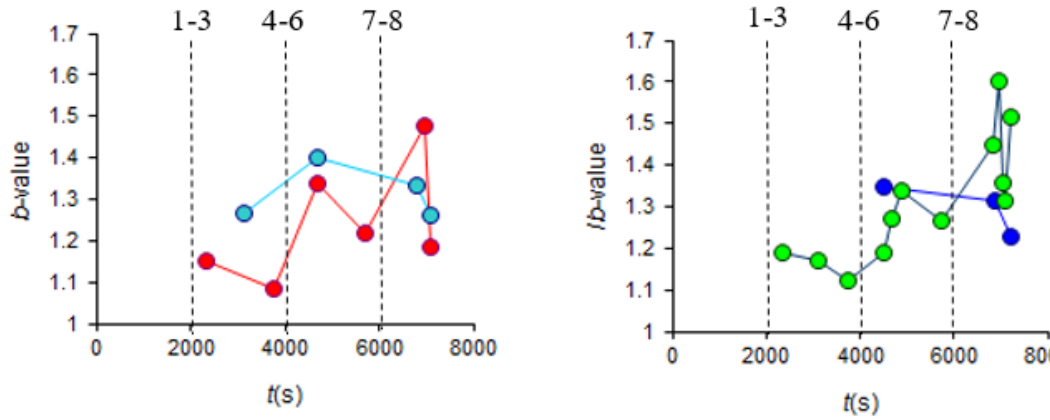
Figure 8. b -value time histories with dashed lines referring to the load stages of Figure 5. Using disjoint subsets of N = 100 (red dots) and N = 150 signals (cyan dots) ( left ). Ib -value with overlapping subsets of N = 100 events with step 25 (green dots) and b -value by a stage-based partition (blue dots) (right).